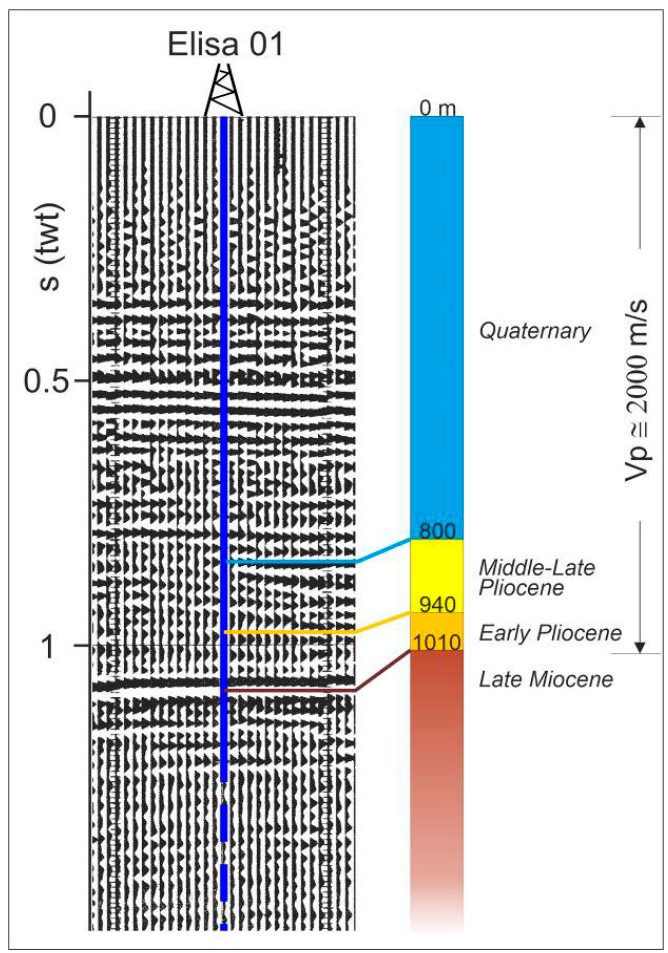
Figure 3. Stratigraphic correlation between the ELISA 1 well and a segment of the ViDEPI B-441 seismic profile where the well is placed (Figure 1).